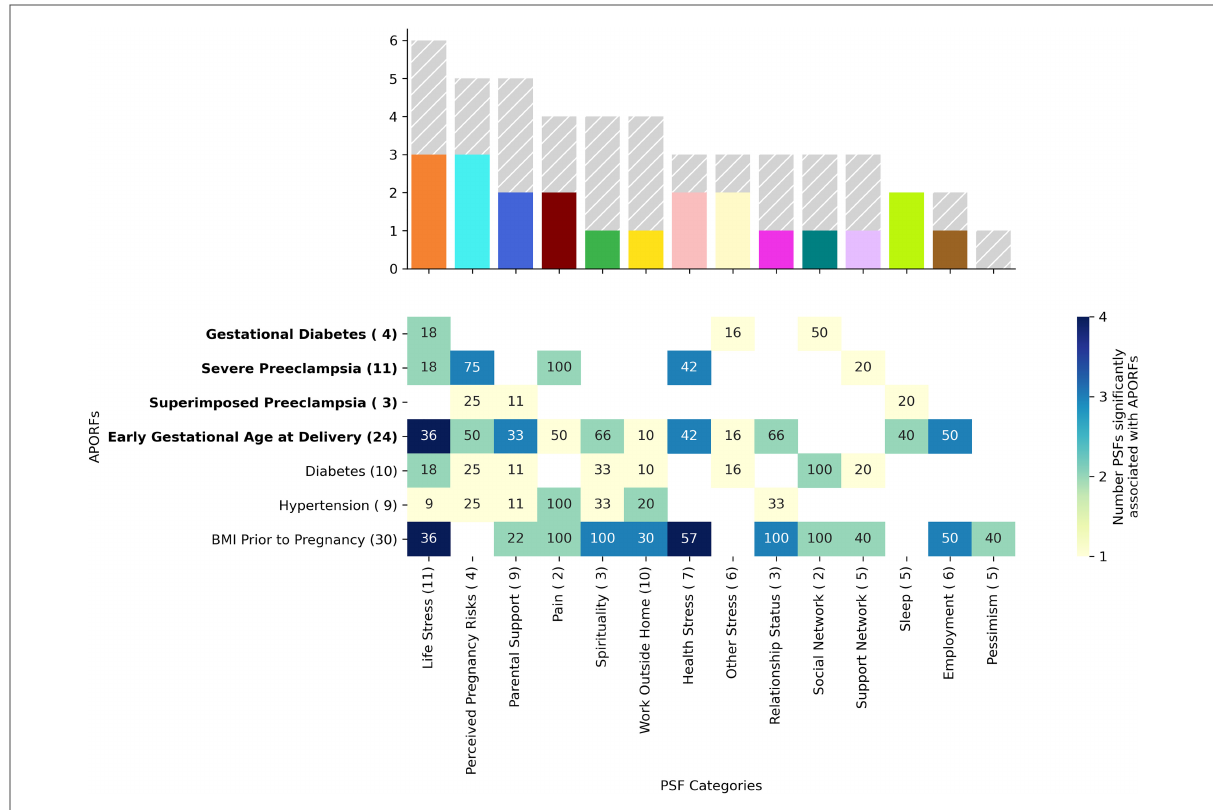
FIGURE 4 APORFs associated with categories of PSFs. The bar plot depicts the number of APORFs that are associated with each stress category ( Supplementary Figure S4 ). Numbers adjacent to each APORF depict the number of categories signi fi cantly associated with each APORF. The height of the colored bar depicts the number of APOs associated with the PSF category, while the height of the gray bar depicts the number of RFs associated with the PSF category. The heatmap depicts the speci fi c APORFs correlated with the PSF cluster, with darker colors representing a greater number of features from the cluster correlated with the outcome. The numbers in the heatmap represent the percentage of features from the cluster that was signi fi cant for the APORFs. The number of features in each cluster is stated in parentheses after each x-axis label. The life stress category was connected to the highest number of